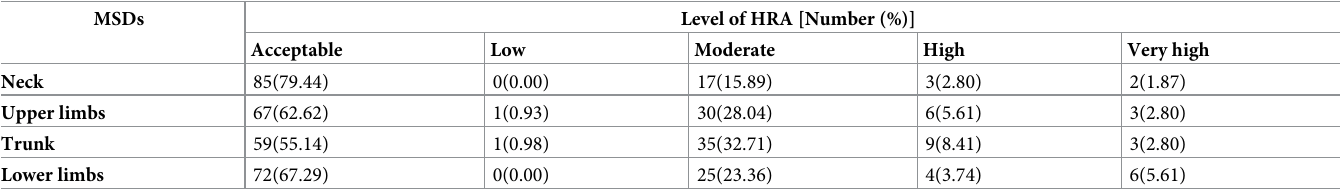
Table 4. The number and percentage of potato-chips processing workers classified by level of MSDs risk by combined matrix scores (n = 107).